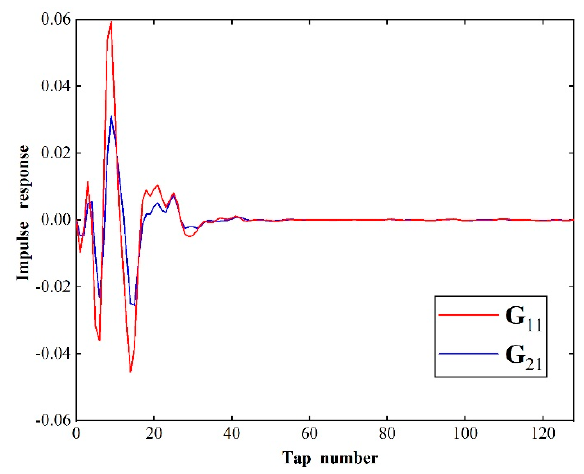
Figure 6. The impulse response (IRF) between left speaker 1 and two error microphones.